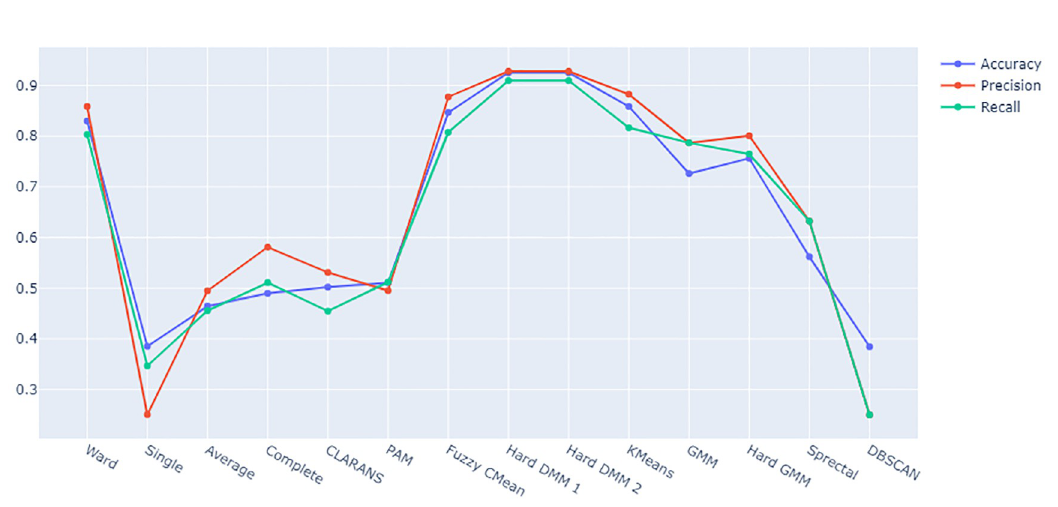
Fig 6. Plot of accuracy, precision and recall of different clustering algorithms on data generated under scheme